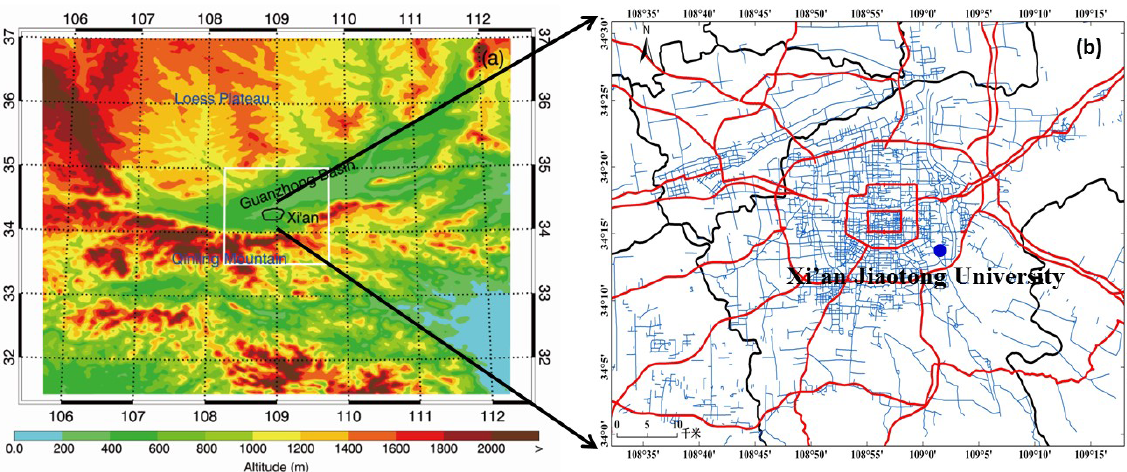
Figure 1. Regional and local maps of the study area: (a) regional map showing the location of Xi’an and the surrounding geography; (b) local map of Xi’an showing the sampling site (blue dot), main roads (red lines), and secondary roads (blue